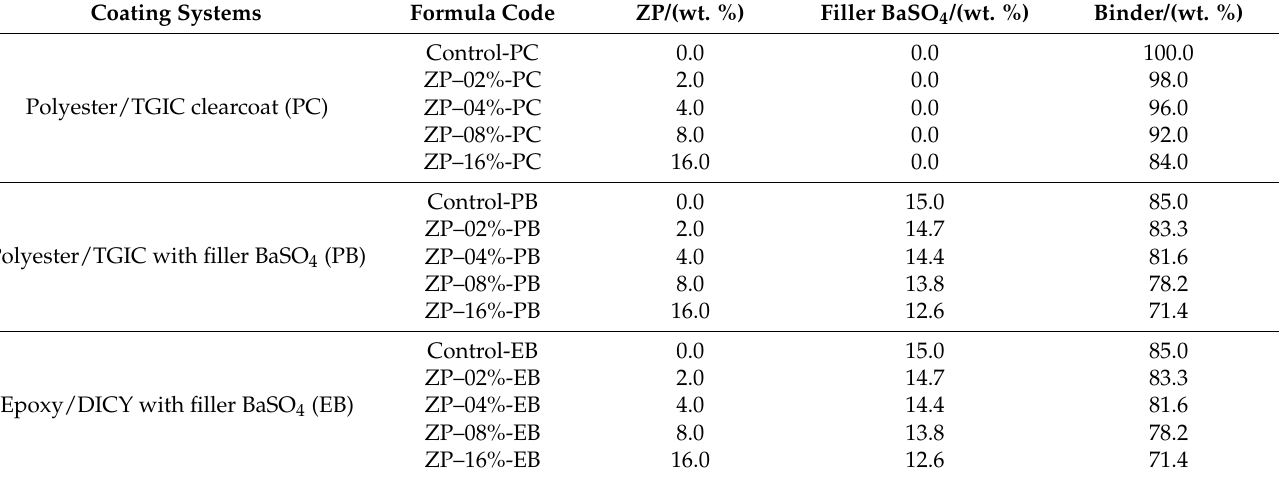
Table 3. Coating formulae in polyester/TGIC clear binder (PC), black polyester/TGIC with filler (PB), and black epoxy/DICY with filler